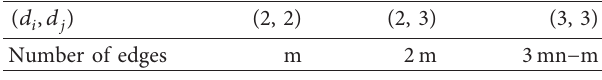
Table 3: Edge partition of TUAC vertices of each edge.